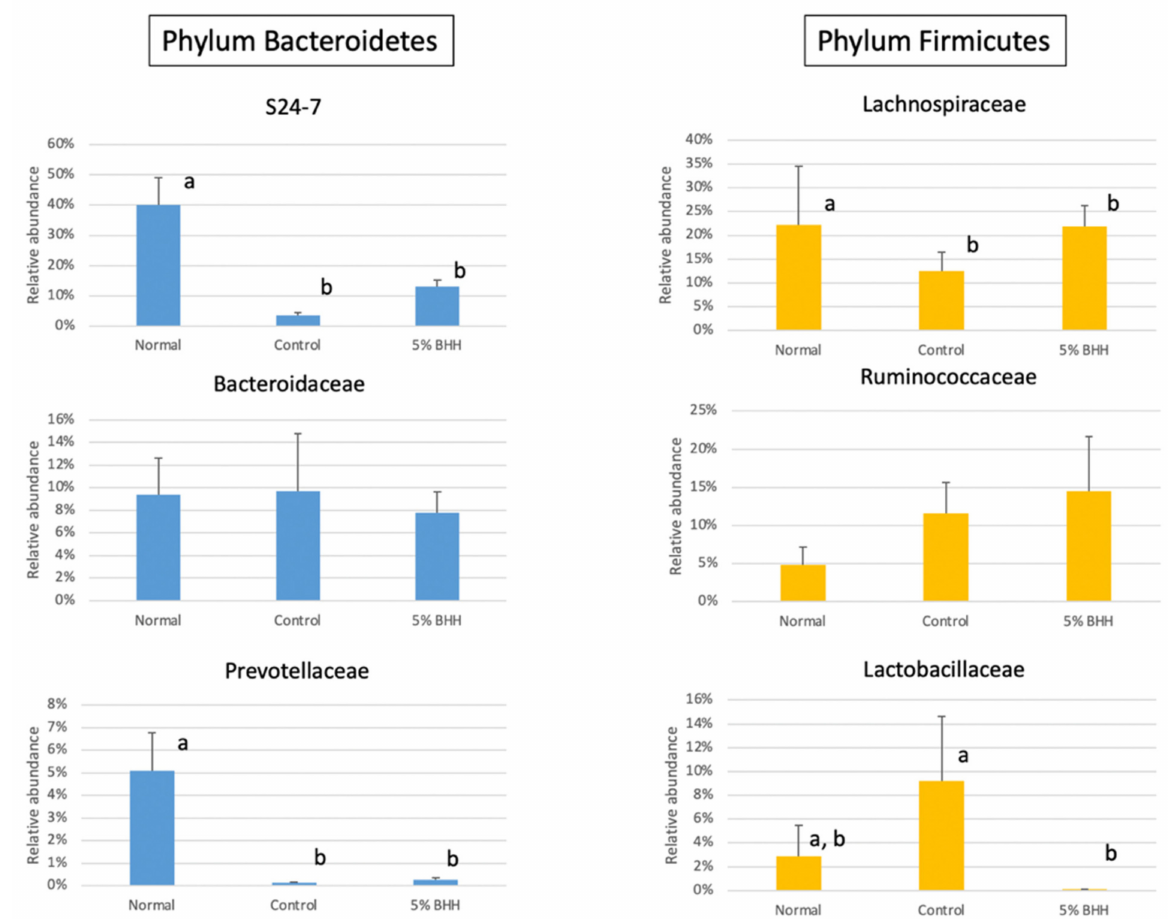
Figure 6. The differential relative abundance of taxa within the Bacteroidetes and Firmicutes phylum among each treatment group, Normal, Control, and 5% BHH. Error bars represent the mean ± standard deviation. Different letters above the bars indicate significant